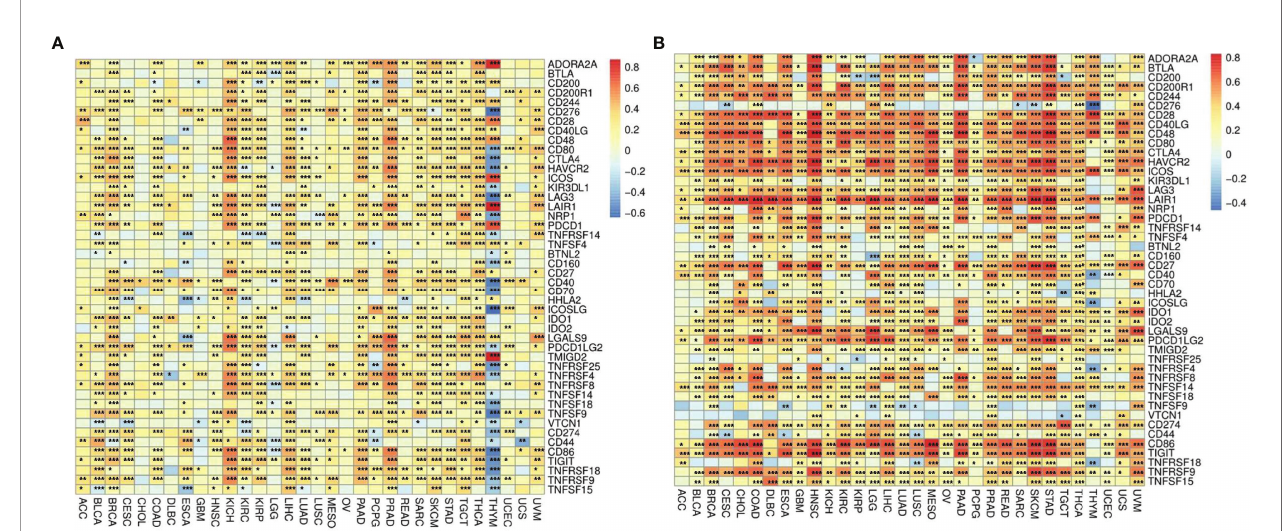
FIGURE 5 | The correlations between ADA1, ADA2, and immune checkpoints. (A) The correlations between ADA1 and con fi rmed immune checkpoints in multiple cancers. (B) The correlations between ADA2 and con fi rmed immune checkpoints in multiple cancers. *p < 0.05, **p < 0.01, ***p < 0.001.